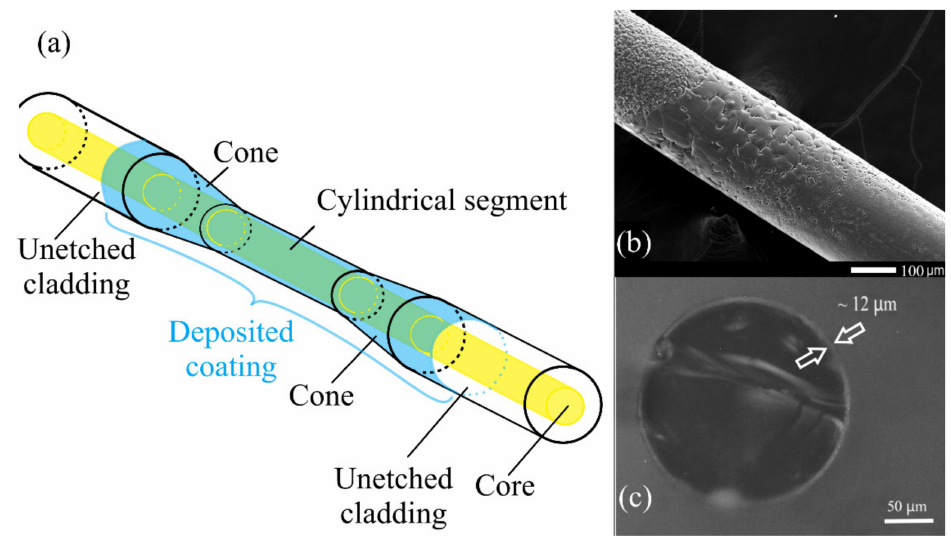
Figure 4. The sensitive part of the fiber: ( a )—diagram of the thinned part of the fiber, ( b )—SEM image of the surface, ( c )—a picture of the end of a taper with a film, magnified in an optical